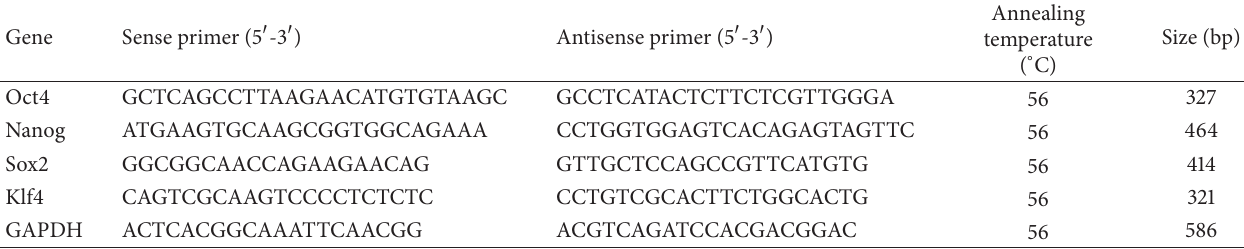
Table 3: Primers used for reverse-transcription polymerase chain reaction.